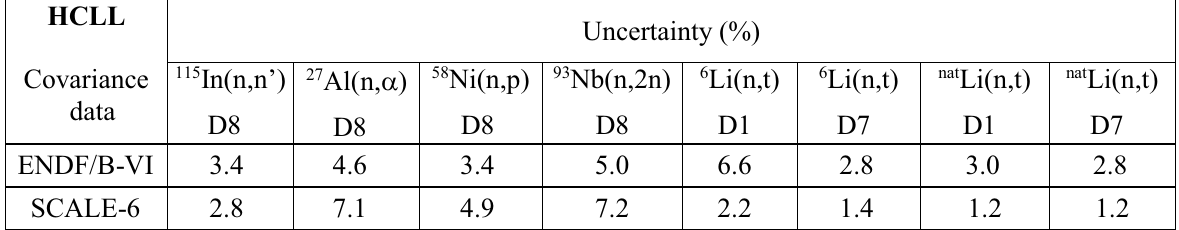
Table III. Total uncertainty in the calculated reaction rates for FNG HCLL benchmark based on JEFF- 3.3 and SCALE-5.0 covariance matrix evaluations (SUSD3D results based on the DORT neutron